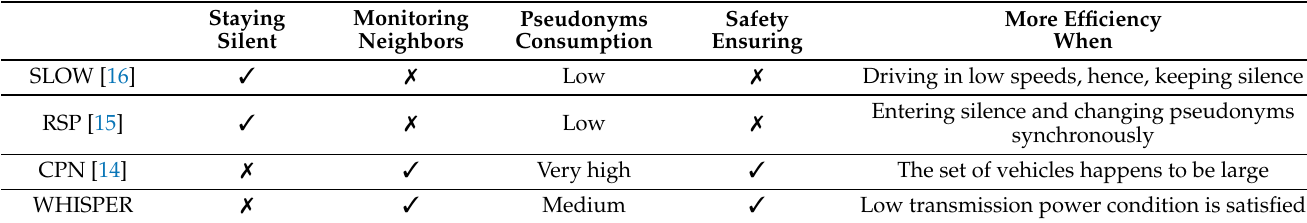
Table 4. A brief comparison of SLOW, RSP, CPN, and WHISPER strategies according to a set of